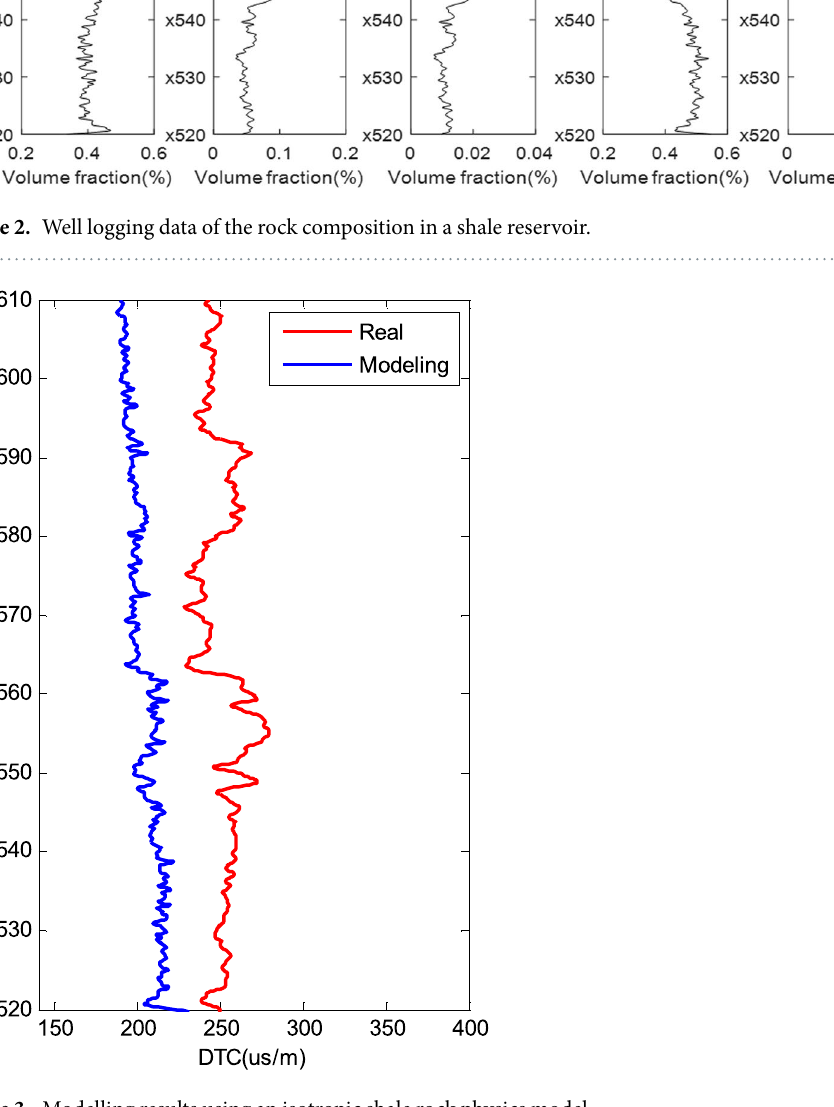
Figure 3. Modelling results using an isotropic shale rock physics